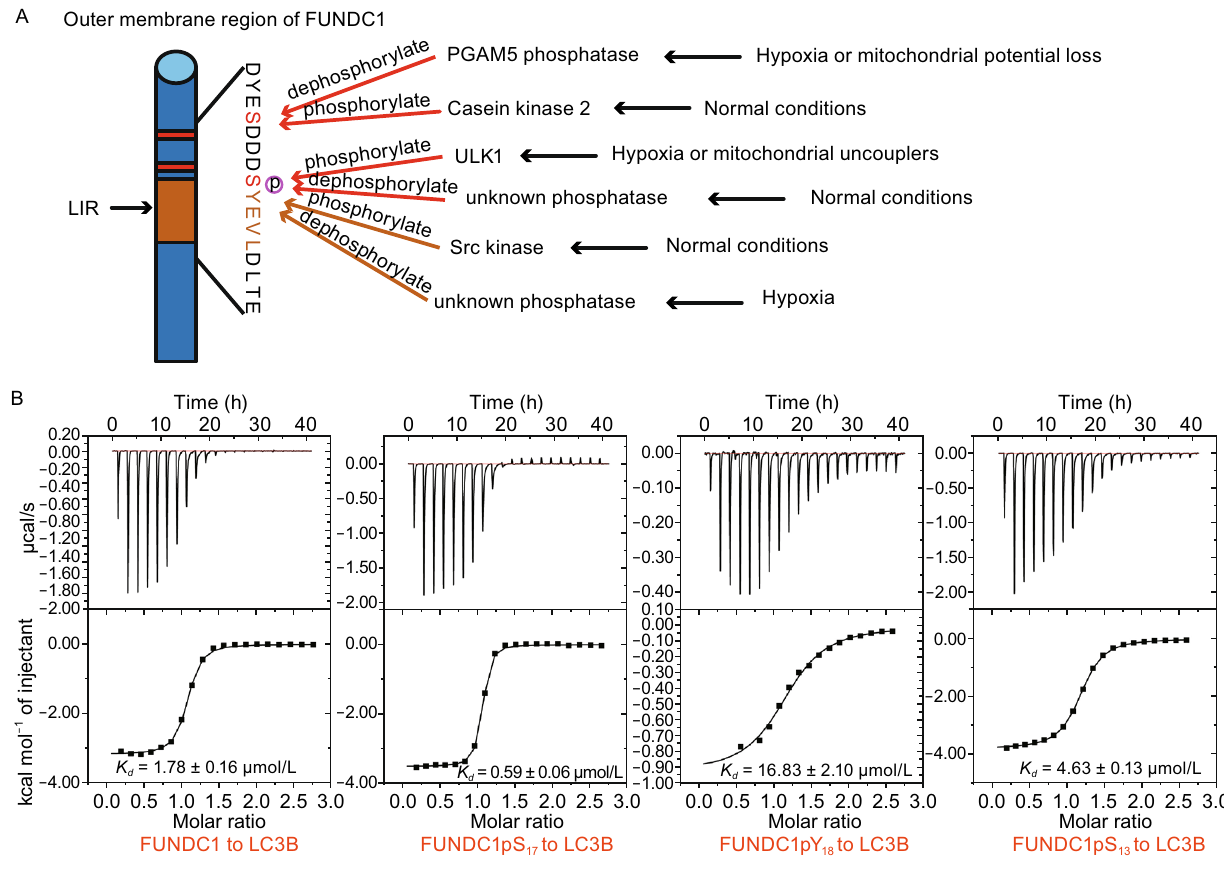
Fig. 1. The signaling pathways of FUNDC1-mediated mitophagy are regulated by phosphorylation modi fi cation. (A) Schematic representation of reversible phosphorylation at critical sites in the FUNDC1 mitochondrial outer membrane region. (B) The ITC fi tting results of LC3B with unphosphorylated FUNDC1 peptide and FUNDC1 peptides phosphorylated at different